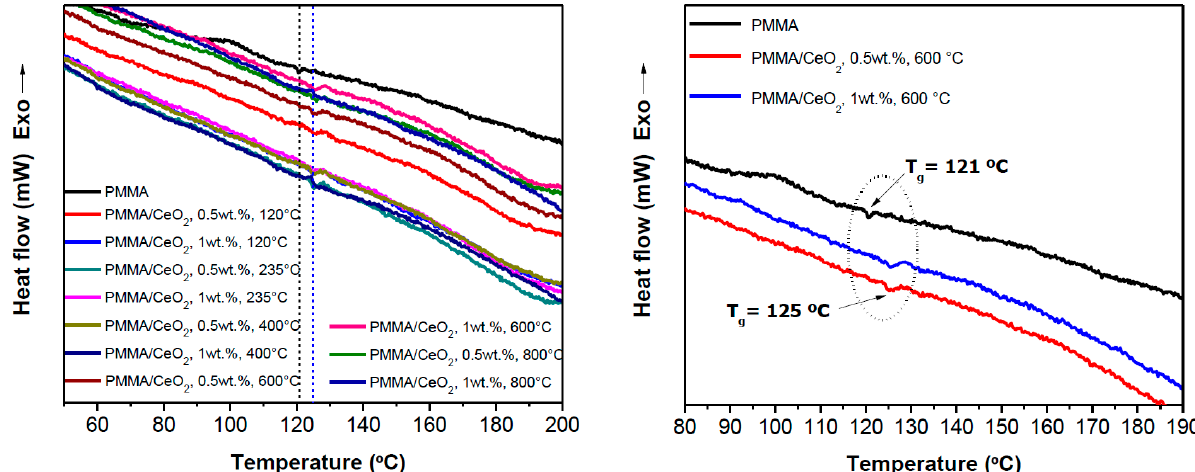
Figure 13. DSC thermograms of the pure PMMA and PMMA/CeO 2 hybrid systems.